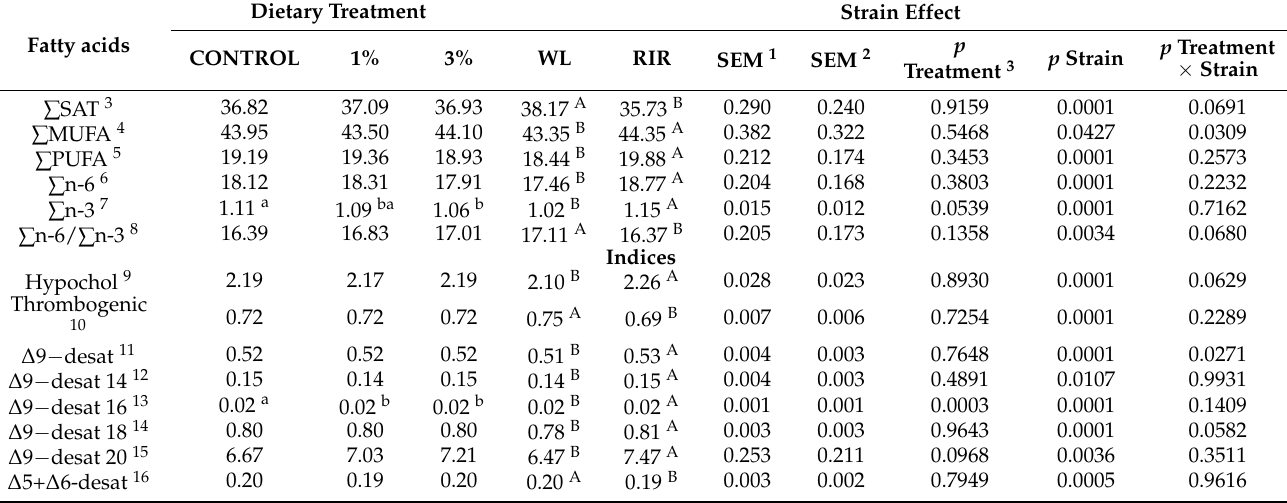
Table 6. Effect of dietary spirulina and strain (White Leghorn: WL or Rhode Island Red: RIR) on the main fatty acids (g/100 g total fatty acids) and different indices of